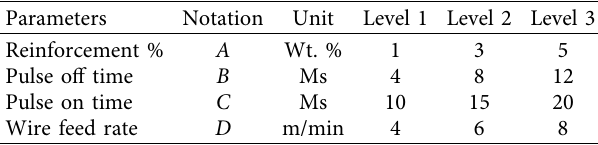
Table 1: Machining parameters and respective